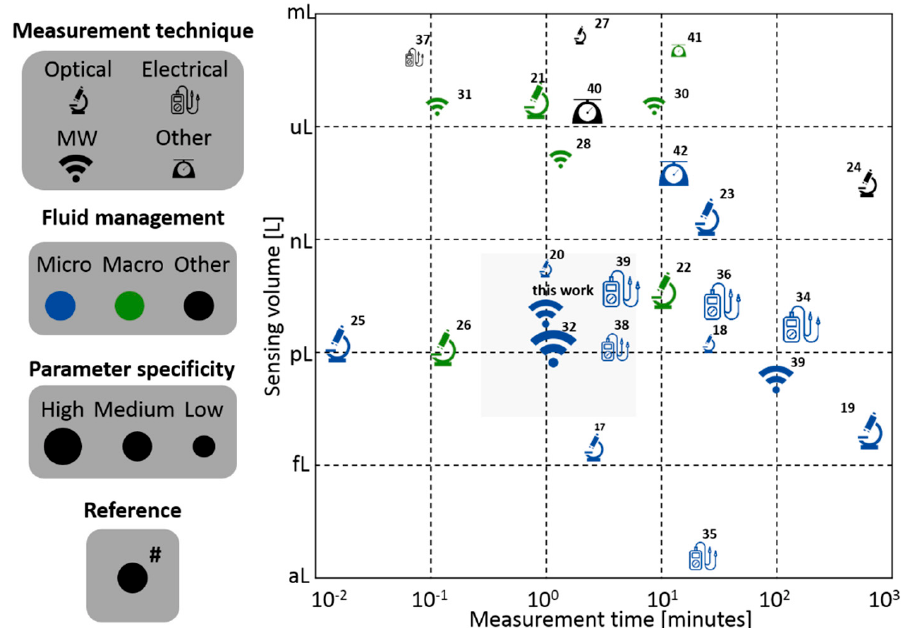
Figure 2. Comparison of several methods for bio-particle detection techniques reported in the literature (optical, microwave, electric and others). In order to compare the different measurement times for different total analyzed volumes, the time was normalized to the equivalent time required to analyze a volume of 100 µ L. Fluid management is divided into micro, macro and other. The parameter specificity is divided into high, medium and low.